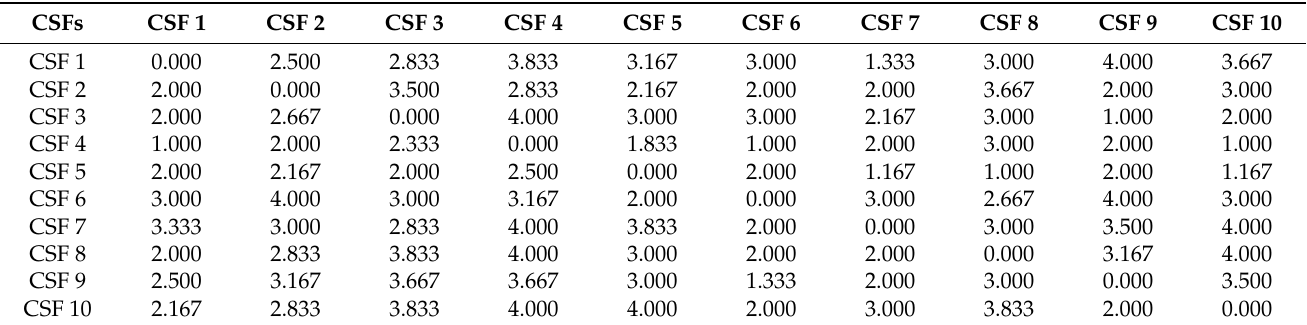
Table 4. The overall direct relationship matrix (A).